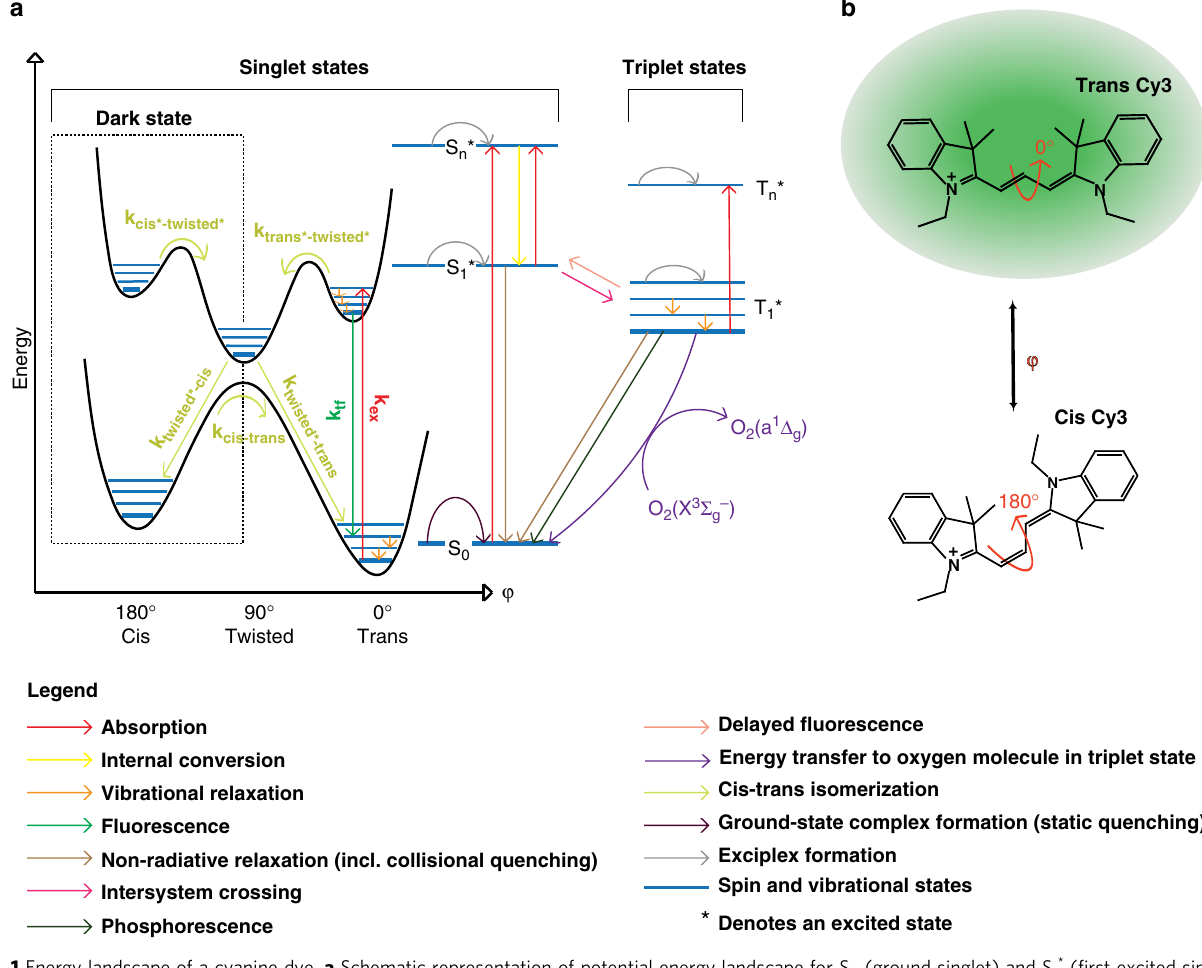
Fig. 1 Energy landscape of a cyanine dye. a Schematic representation of potential energy landscape for S 0 (ground singlet) and S 1 * ( fi rst excited singlet) states as a function of single dihedral angle of the Cy3 polymethine bond, superposed on a Jablonski diagram. b Schematic representation of the Cy3 dye molecule and one of its dihedral angles, in fl uorescent trans and dark cis con fi